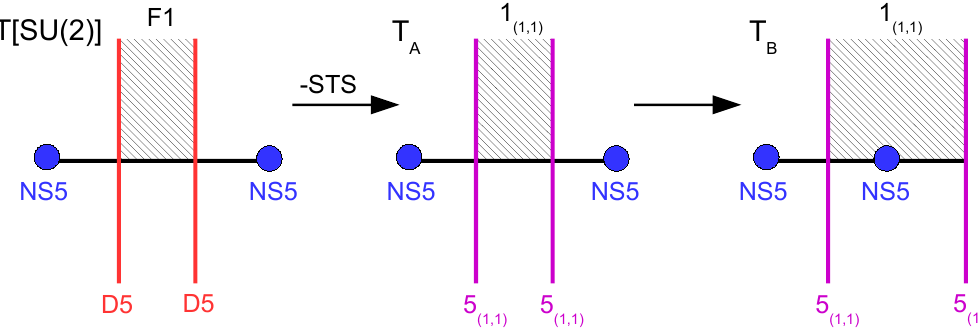
Figure 13 . The brane realization of the meson operator Z 2 1 in T [SU(2)] becomes the setup for u + in T A and the setup for v + in T B , by SL(2 ; Z ) action and 5 brane II